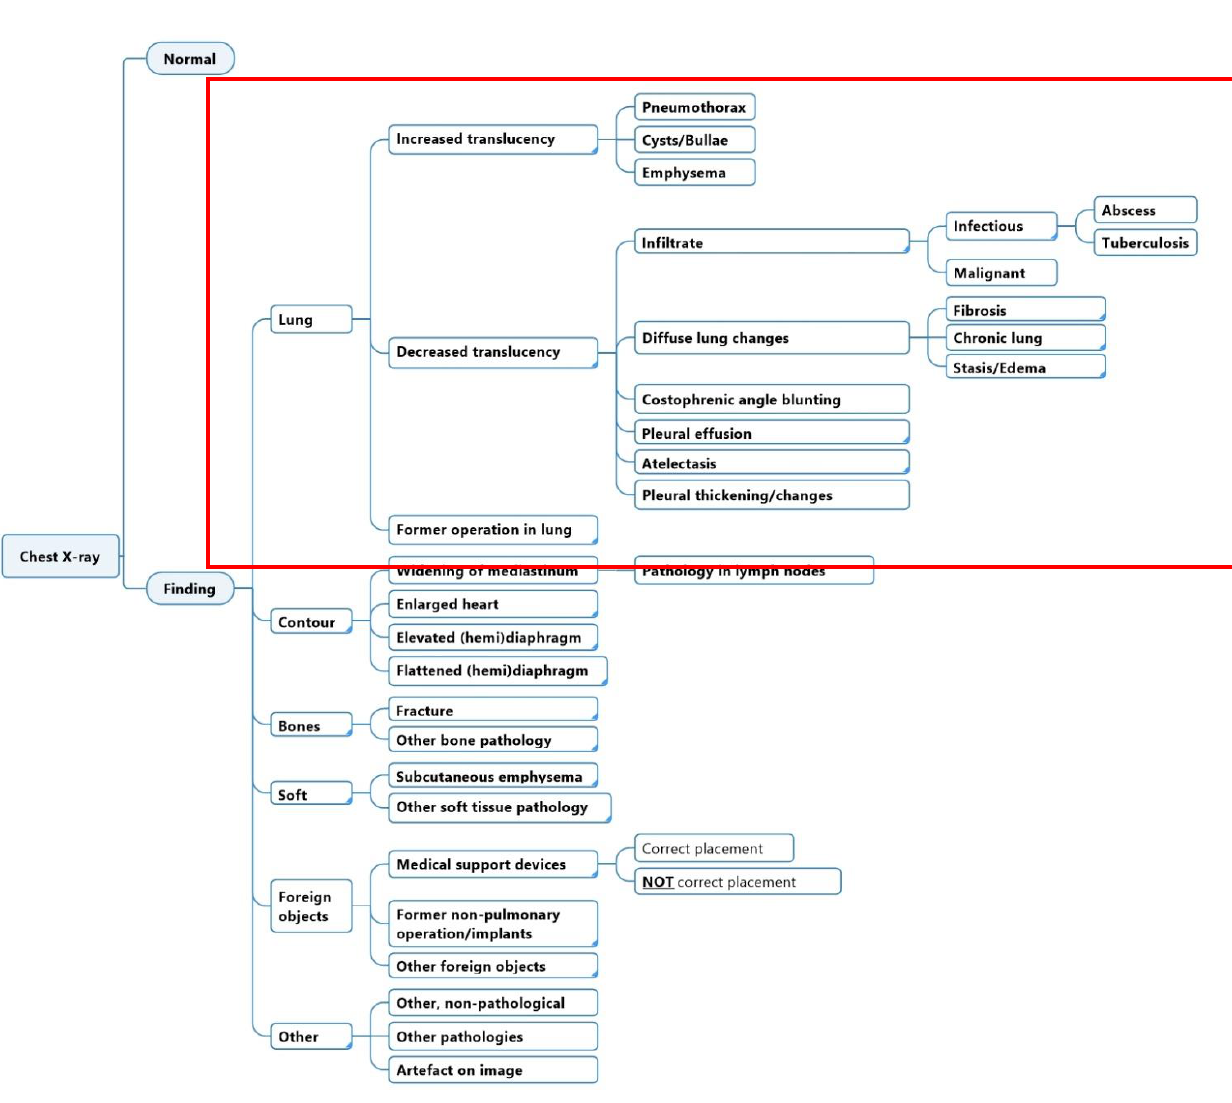
Figure 1. Full diagnostic labeling scheme and annotation labels for lung tissue findings in the diagnostic labeling scheme (red square).